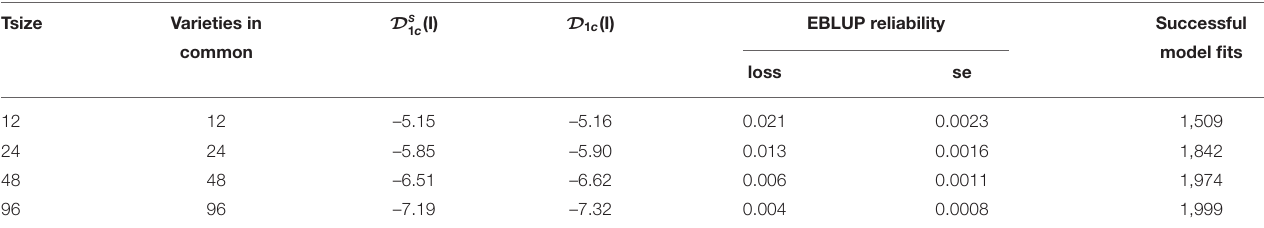
TABLE 3 | Independent VE effects simulation study: Summary of key results for each trial size and the case of 100% connectivity between the two trials: Simulation based D